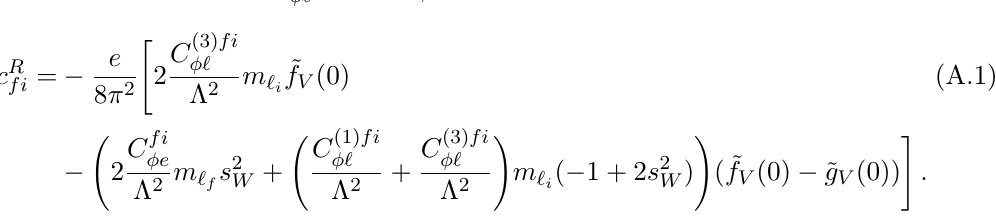
Table 7 . Conversion factors from the tree-level results for ‘ → 3 ‘ 0 to the dominant (just one flavour off-diagonal vertex) tree-level contribution to ‘ → ‘ 0 ‘ 00 ‘ 00 . No value is given for the VLL N since both Br( ‘ → ‘ 0 ‘ 00 ‘ 00 ) and Br( ‘ → 3 ‘ 0 ) are zero in this case. For the contributions of C (1 , 3) and C to magnetic transitions we φe φ‘